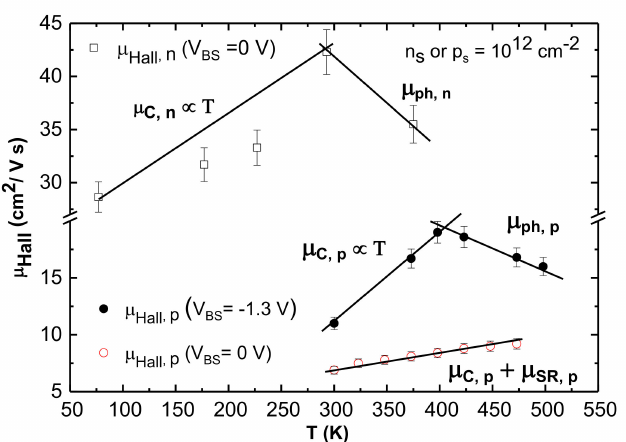
Figure 7. Hall mobility ( µ Hall ) versus temperature T for different body biases is plotted for a = 10 12 cm − 2 . For n-channel MOSFET, Coulomb scattering is dominant below RT; fixed n s /or p s above RT phonon scattering can be observed at zero body bias. However, for p-channel MOSFETs, µ Hall is limited by a combined effect of Coulomb and surface roughness scattering, V BS = 0 V. For V BS = − 1.3 V, µ Hall increases linearly until 398 K (125 ◦ C) due to Coulomb scattering. At higher temperatures, phonon scattering dominates and µ Hall decreases with temperature as T − 0.9 . Error bars signify variation in in at least 3